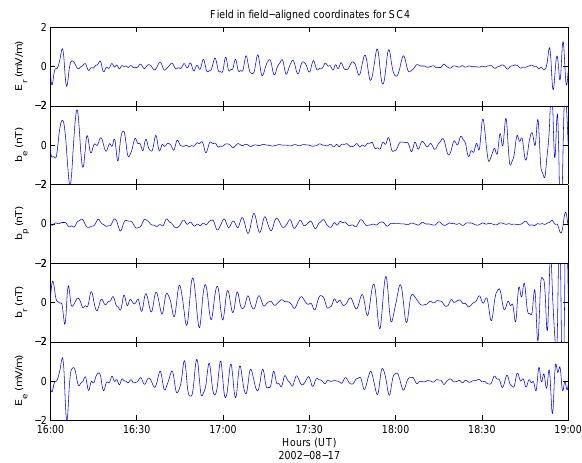
Fig. 5. The electric and magnetic fields in a field-aligned coordinate system for the 17 August 2002 event. The subscript r indicates the meridional, e the eastward and p the field-aligned (parallel) direc- tion.